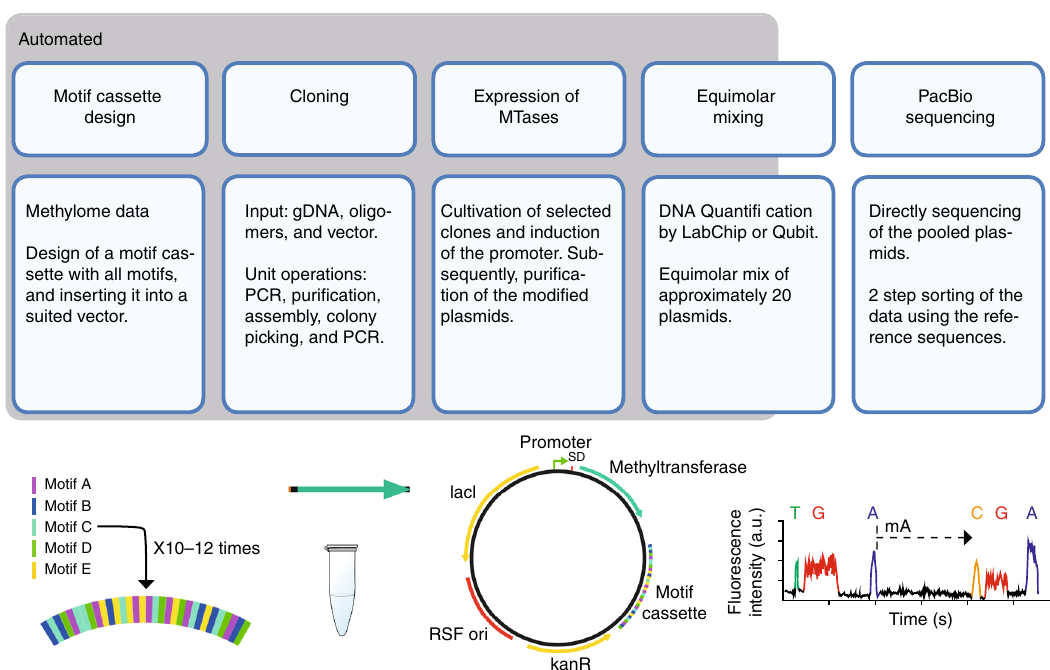
Fig. 1 MetMap work fl ow. The box designated “ automated ” indicates the steps that were automated. The variance in the occurrence of motifs in the motif- cassette depends on the nature of the motifs; A motif including unspeci fi c regions of 2 – 10 n ’ s (typical for Type I motifs) is present 12 times in the cassette, whereas motifs not including such regions is repeated 10